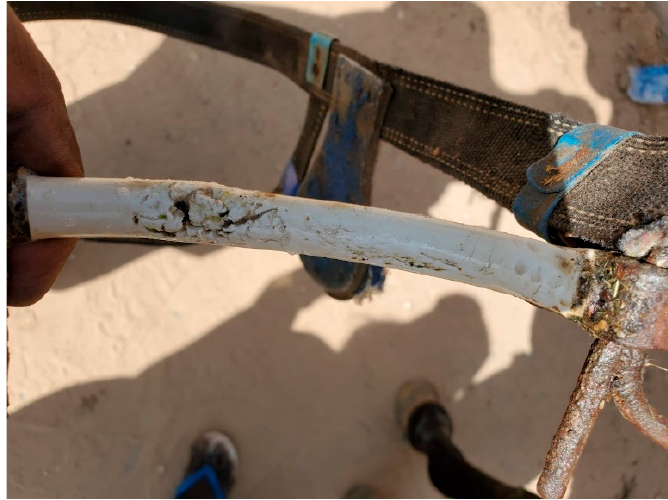
Figure 9. Damage occurring to plastic coating during testing phase; hence removal of this prototype from further trialling and scale-up.